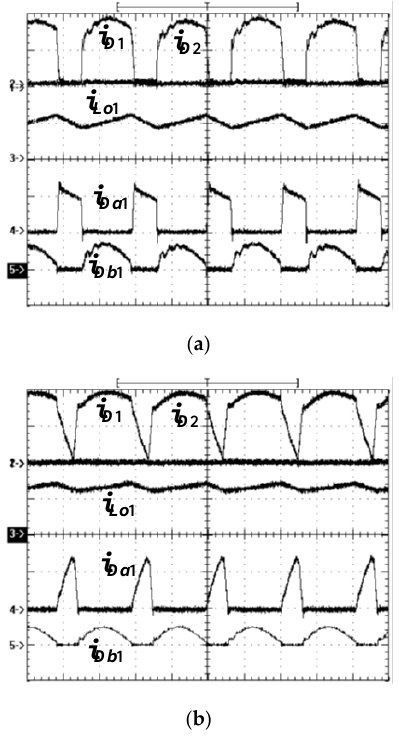
Figure 10. Measured waveforms of the secondary-side currents in first full bridge circuit ( a ) 20% load (i D1 , i D2 , i Lo1 , i Da1 , i Db1 : 5 A / div; time: 4 µ s / div) and ( b ) full load (i D1 , i D2 , i Lo1 , i Da1 , i Db1 : 20 A / div; time: 4 µ s / div).